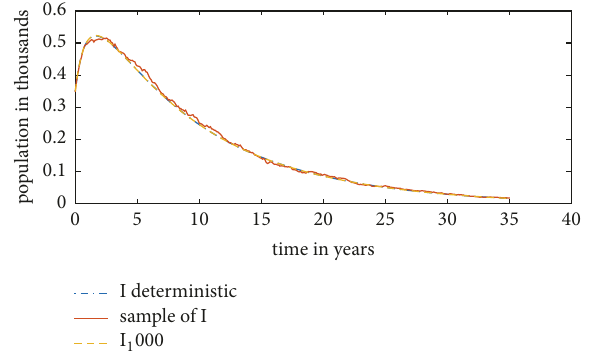
Figure 3: 𝑅 0 = 1.1562 , 𝑅 𝜎 = 0.0.9298 , and 𝑐 1 = 0.000054 , 𝜎 = 0.04 .